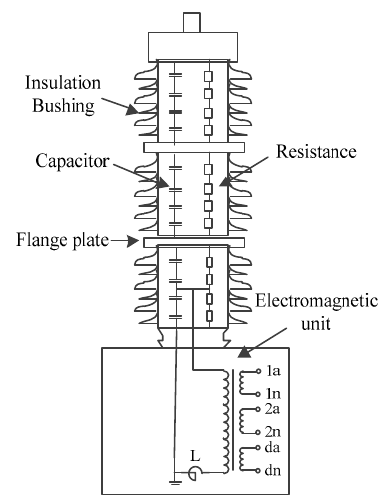
Figure 15. Structure of low-voltage CVT model.